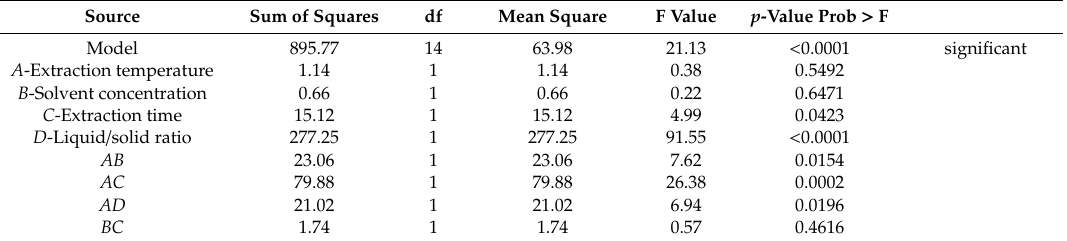
Table 3. Variance analysis of extracted equation of flavonoids from mulberry